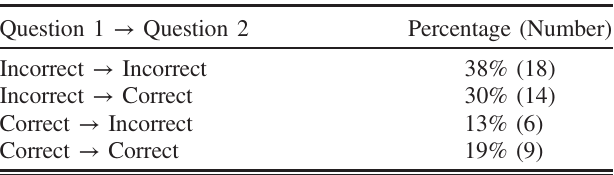
TABLE II. Response patterns for students who answered both question 1 and question 2 ( N ¼ 47 ).